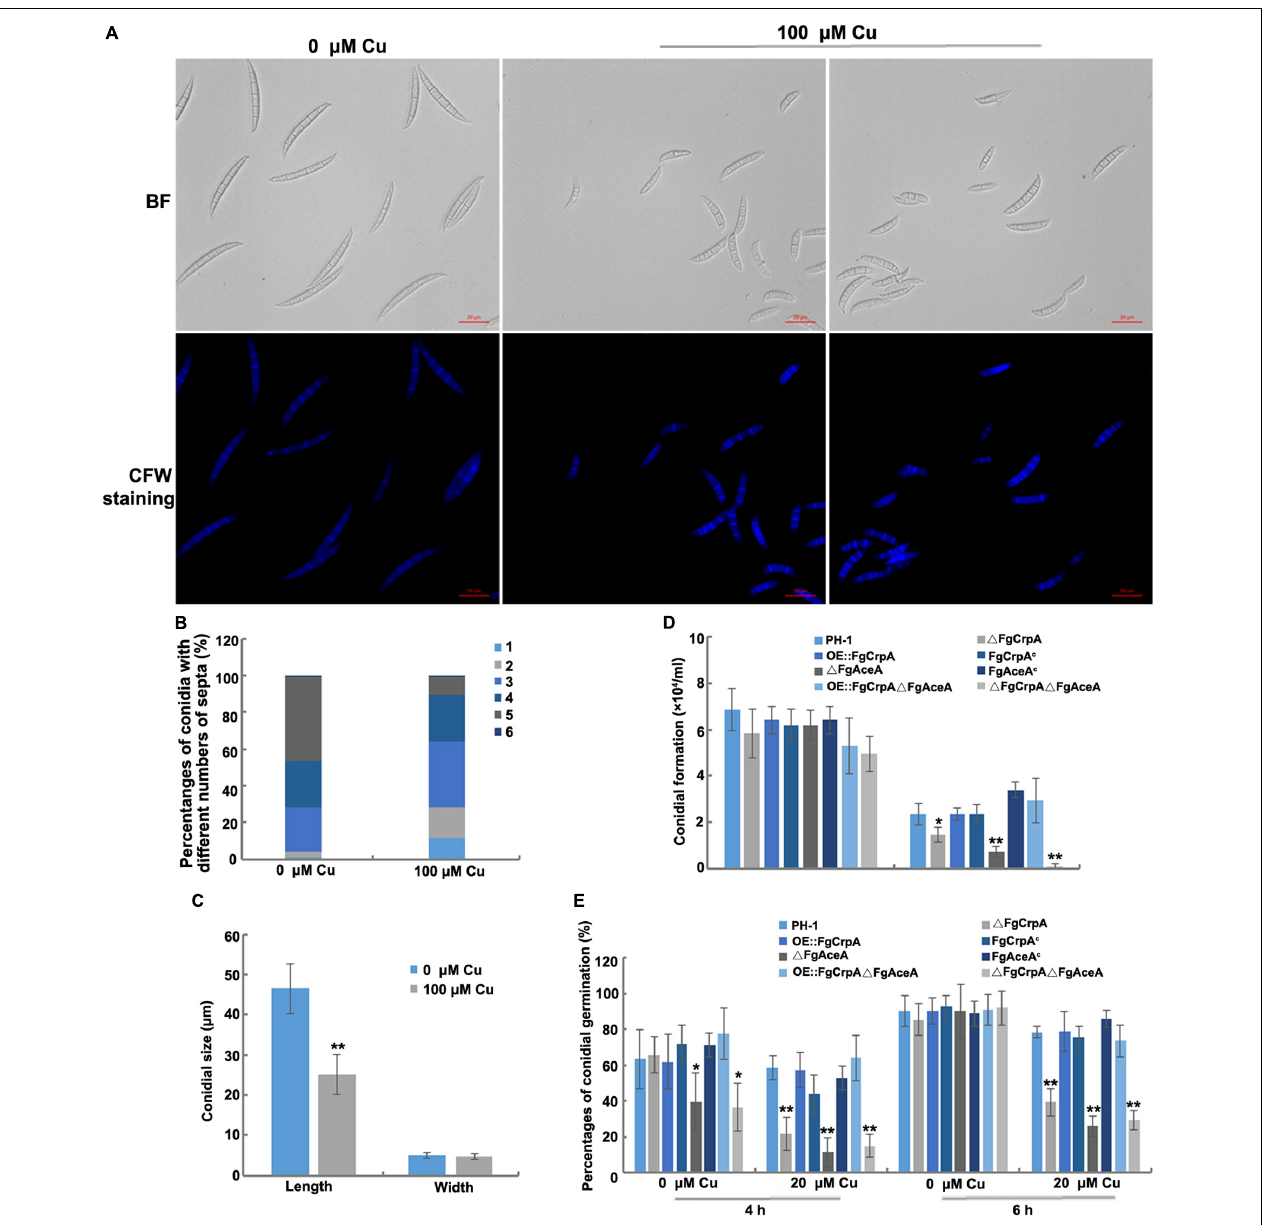
FIGURE 3 | Excess Cu treatment caused defects in conidial morphogenesis. Differences in F. graminearum conidial morphology (A) , numbers of septa (B) , and conidial size (C) between conidia treated and untreated with Cu at 100 µ M. (D) Conidial formation was measured by inoculating five mycelial plugs taken from wild-type strain PH-1 and its mutants in 50 ml liquid CMC amended with or without CuSO 4 at 20 µ M in a shaker with light at 180 rpm at 25 ◦ C for 3 days. (E) Conidial germination was also compared between wild-type strain PH-1 and its mutants by re-suspending the conidia in 10 ml liquid FMM amended with or without CuSO 4 at 20 µ M in a shaker with light at 180 rpm at 25 ◦ C for 4 h and 6 h. A t -test was performed to determine significant differences, * p < 0.05, ** p < 0.01.